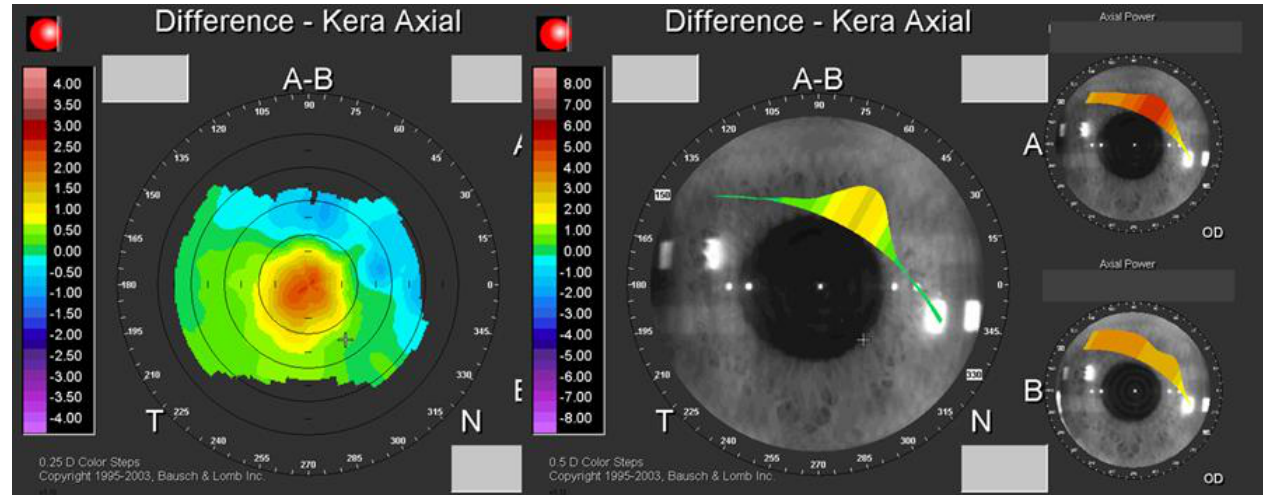
Figure 1. Topographical imaging showing a central steepness of the cornea created using the Supracor PresbyLASIK algorithm.